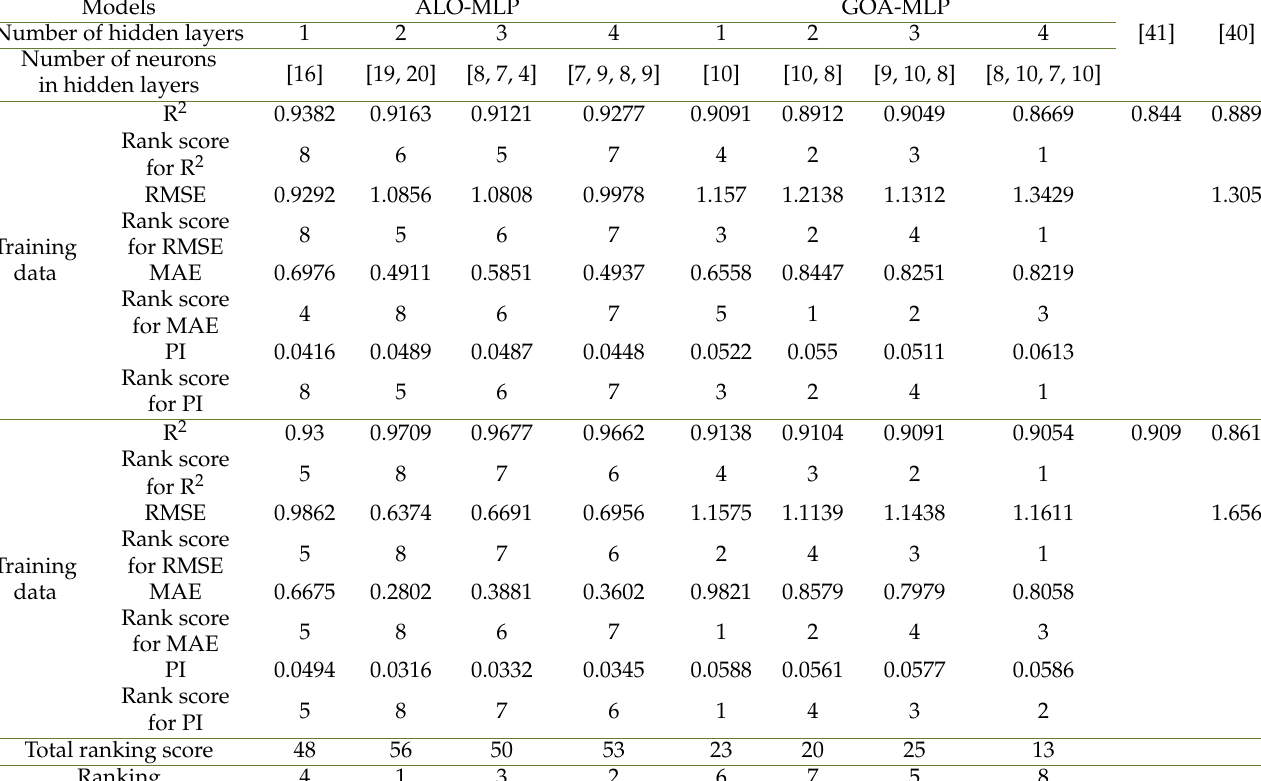
Table 2. The results of created hybrid MLP models for predicting